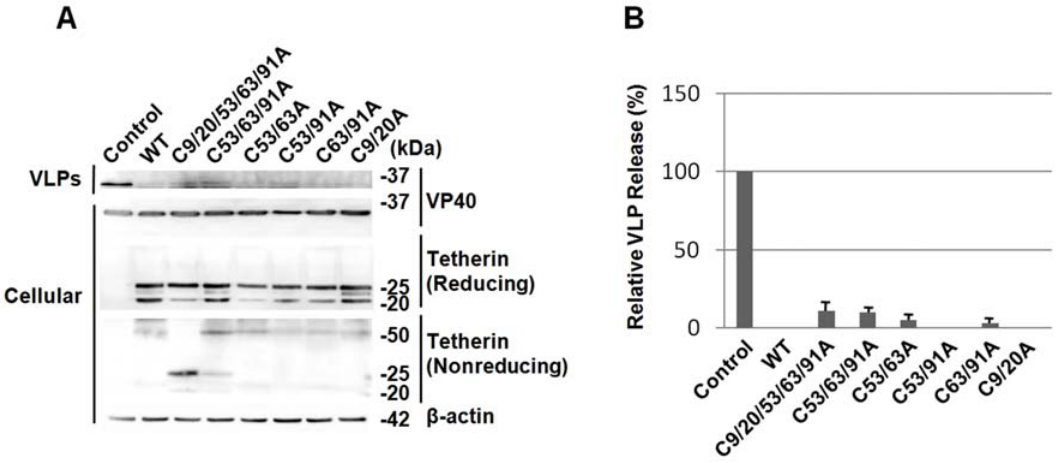
Figure 3. Effects of expression of the cysteine to alanine substitution mutants of tetherin on Marburg VLP production. (A) Marburg virus VP40 protein was coexpressed with WT or mutant tetherin in COS-7 cells. VLP-associated and cell-associated VP40 were analyzed by Western blotting. WT and mutant tetherin expressed in COS-7 cells were analyzed under both reducing and nonreducing conditions by Western blotting. Western blotting for b -actin was performed as an internal control. (C) The intensities of the bands for VLP-associated VP40 in panel A were quantified using a LAS3000 imaging system (Fuji Film). The level of VP40 in VLP released from cells cotransfected with control vector was set to 100%. The data are shown as averages and standard deviations (SD) of 6 independent experiments.